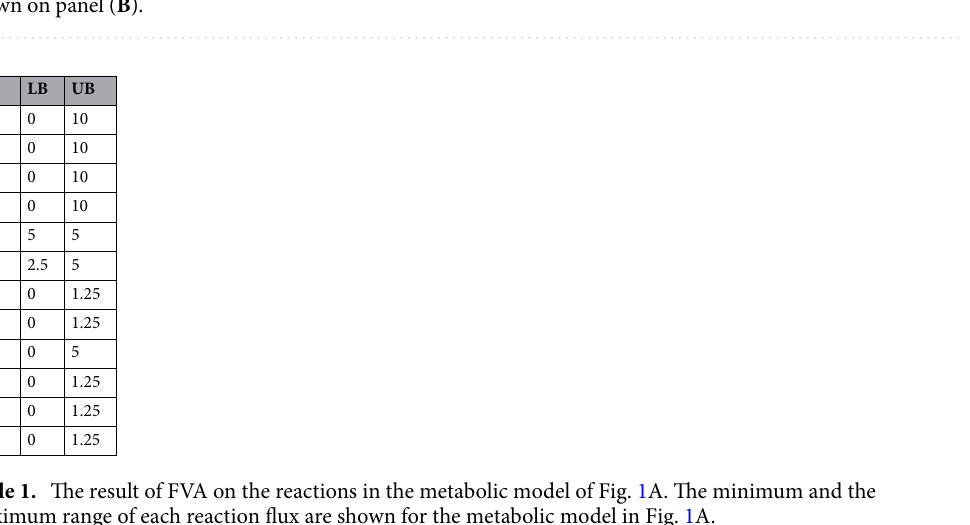
Figure 1. Illustration of flux trade-offs on a paradigmatic network. The toy network is composed of eight metabolites (green nodes) and 12 reactions (blue hyperedges) shown on panel ( A ). Under the constraints that reaction 5 has a flux fixed to 5 (a.u.) and the lower and upper boundaries for the fluxes of the remaining reactions are 0 and 10 (a.u.), there are ten trade-offs (orange edges), each involving two reactions (blue nodes), shown on panel ( B ).